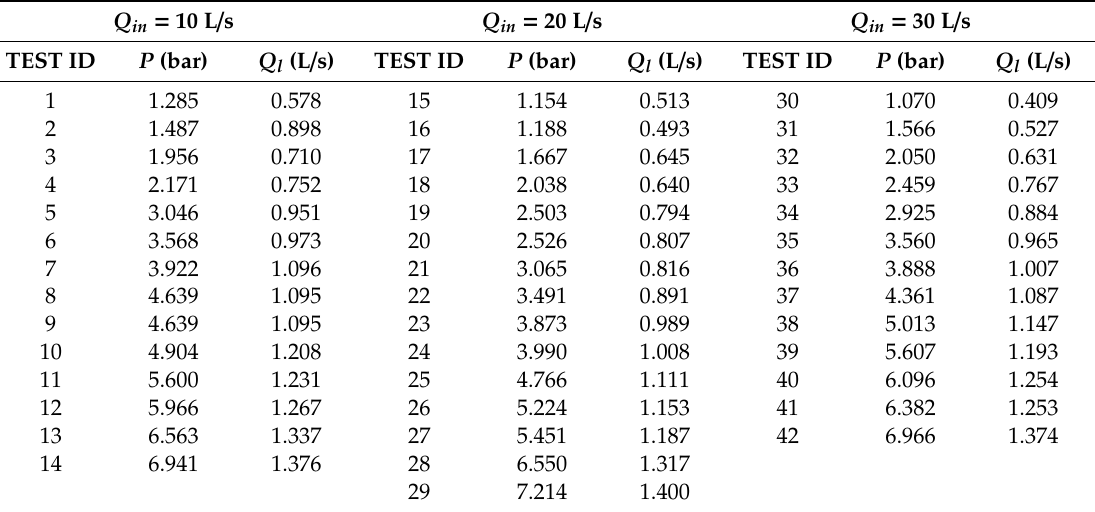
Table 7. Results of experimental static